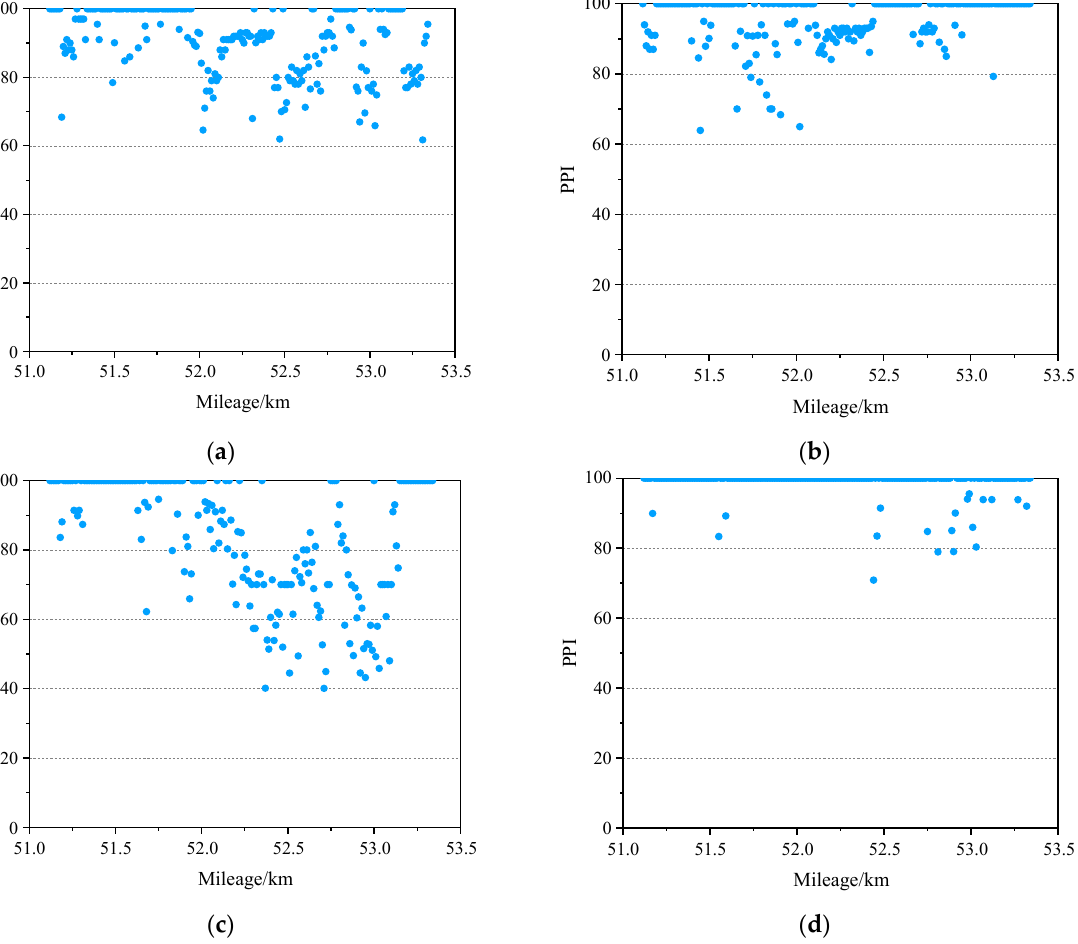
Figure 12. PPIs of XHMB pavement in 2021: ( a ) up direction drive lane; ( b ) up direction pass lane; ( c ) down direction drive lane; ( d ) down direction pass lane.